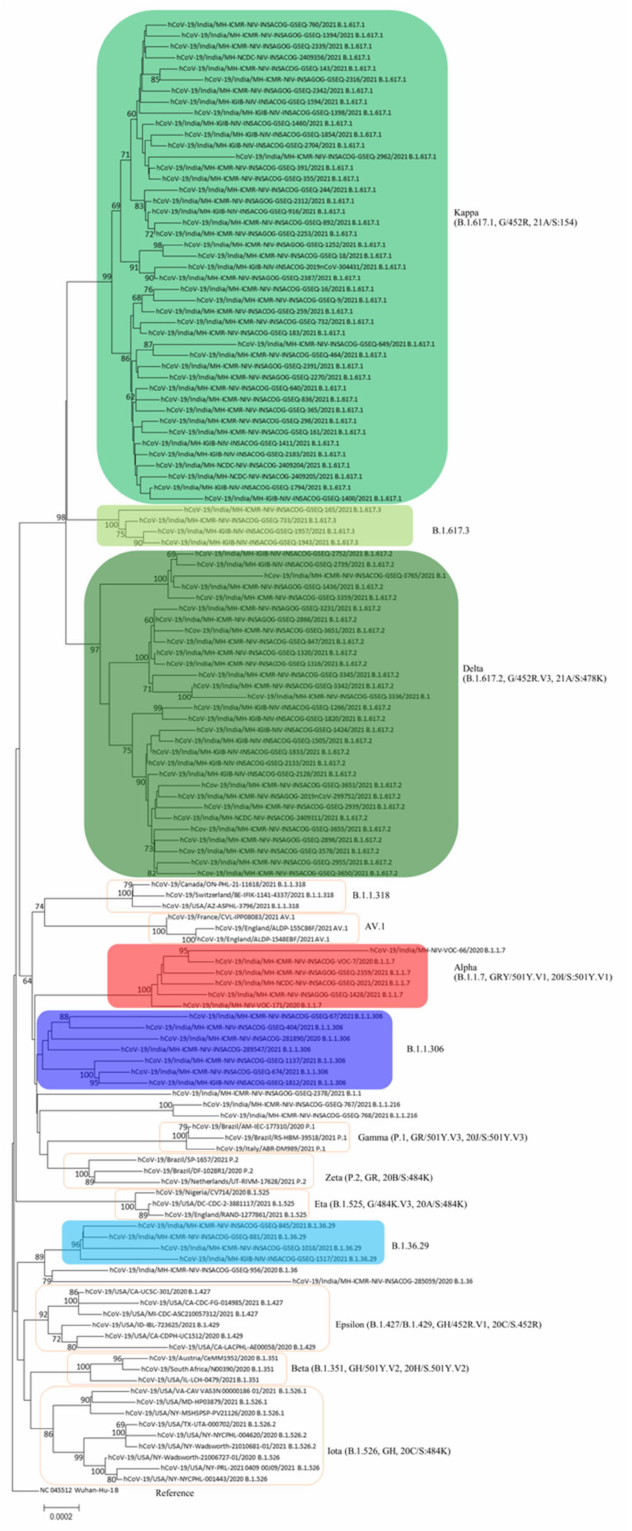
Figure 1. Neighbor-joining tree of representative SARS-CoV-2 genomes depicting lineages in WHO label, PangoLIN, GISAID and Nextstrain. The sequences of this study are tagged as India/MH- ICMR-NIV and major lineages are in colored boxes. Additionally, included are representatives of the global WHO identified VOCs/VOIs/VUIs in unfilled